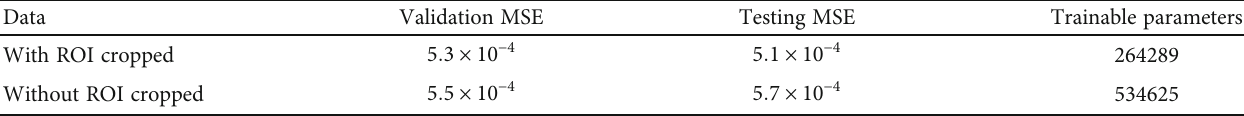
Table 1: Results of training with and without ROI